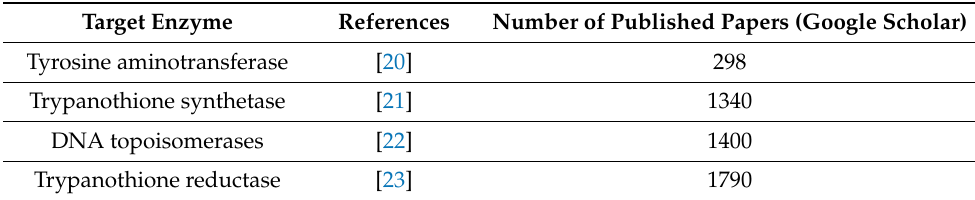
Table 1. Targets enzymes for L. infantum from